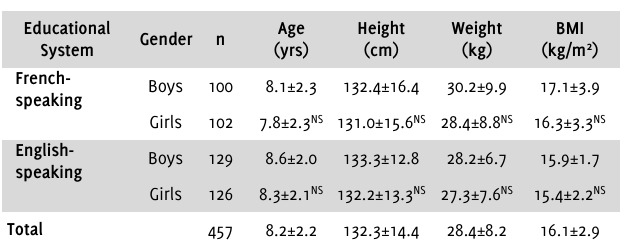
Table 1 . Sociodemographic and anthropometric characteristics of